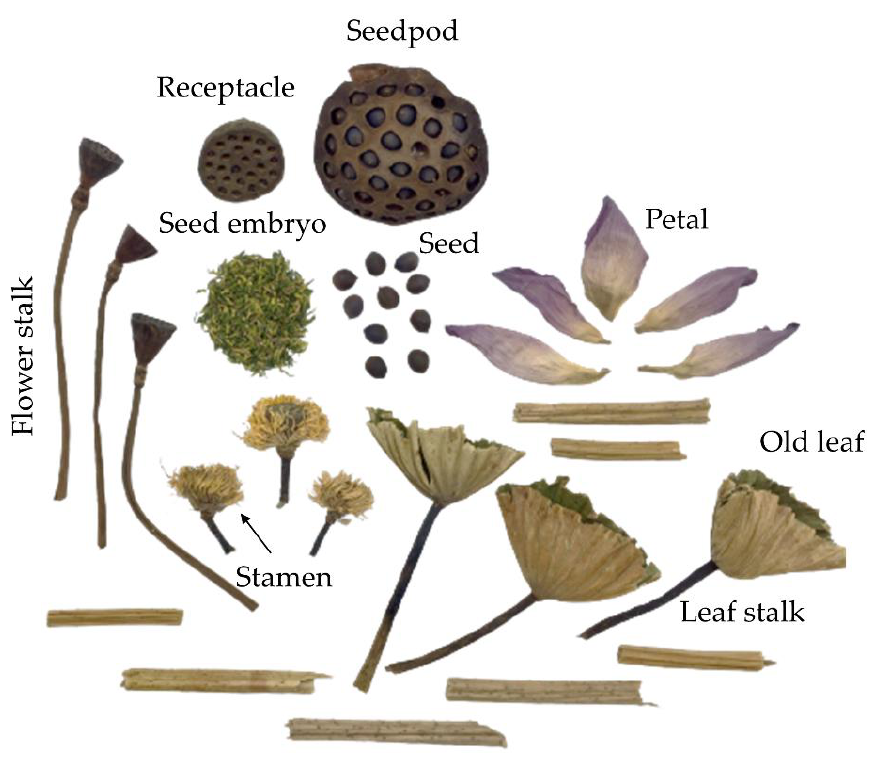
Figure 1. Different sacred lotus parts used in this experiment including seed embryo, petal, stamen, old leaf, leaf stalk and flower stalk.